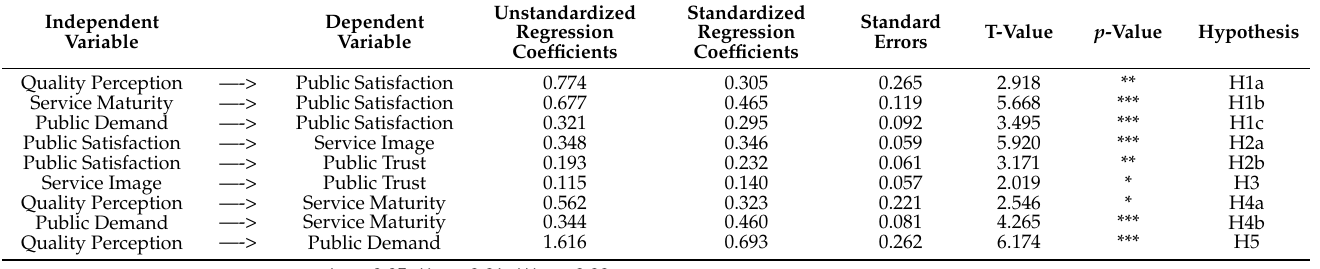
Table 8. The path test.